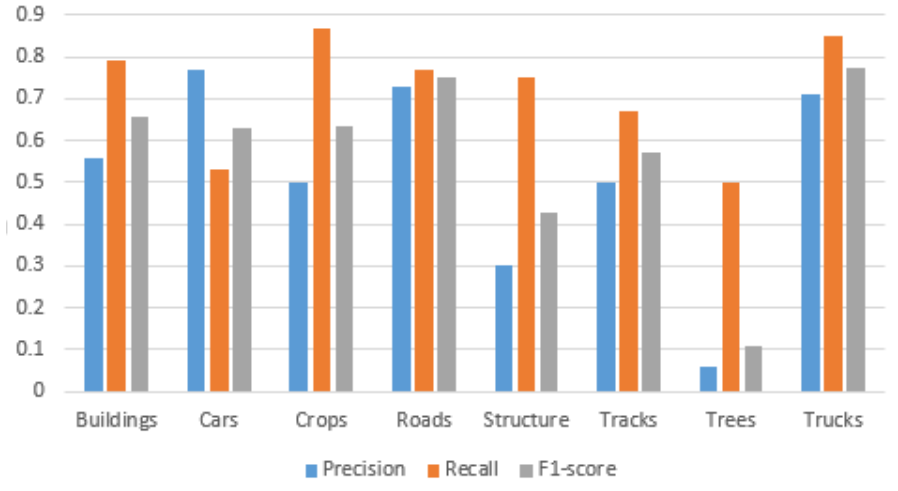
Figure 8. Results obtained with VGGNet for AID datasets.